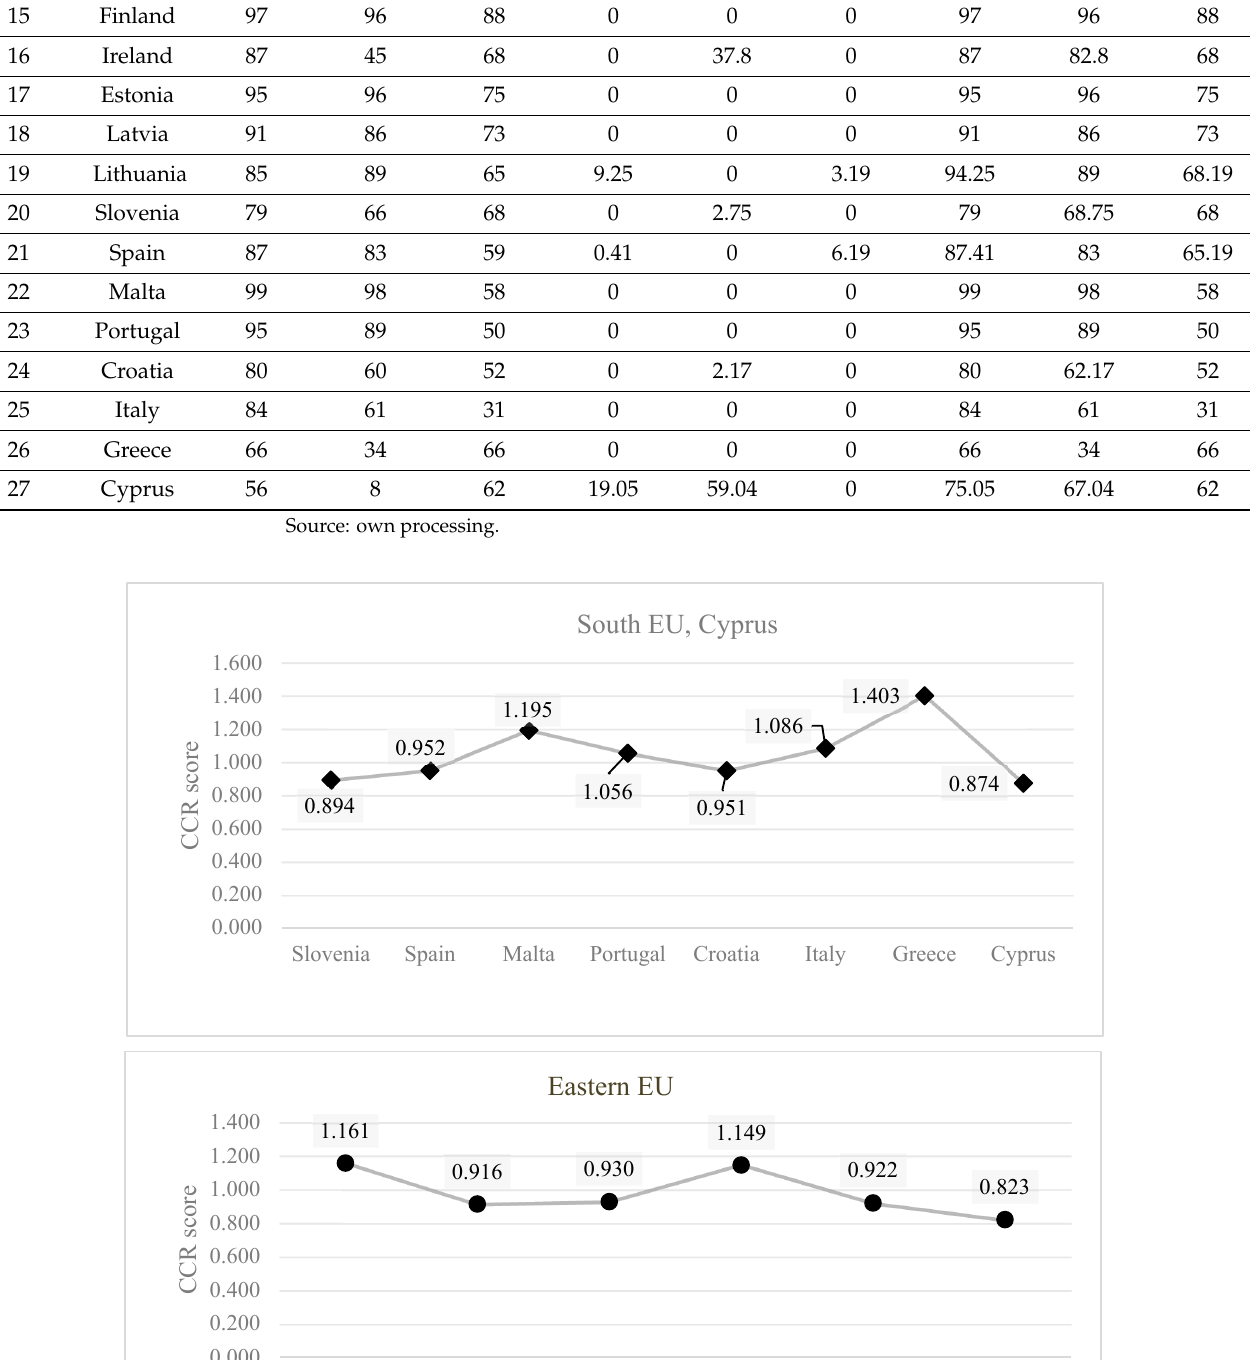
Figure 5. Results of the CCR model in the Western EU. Source: own processing.